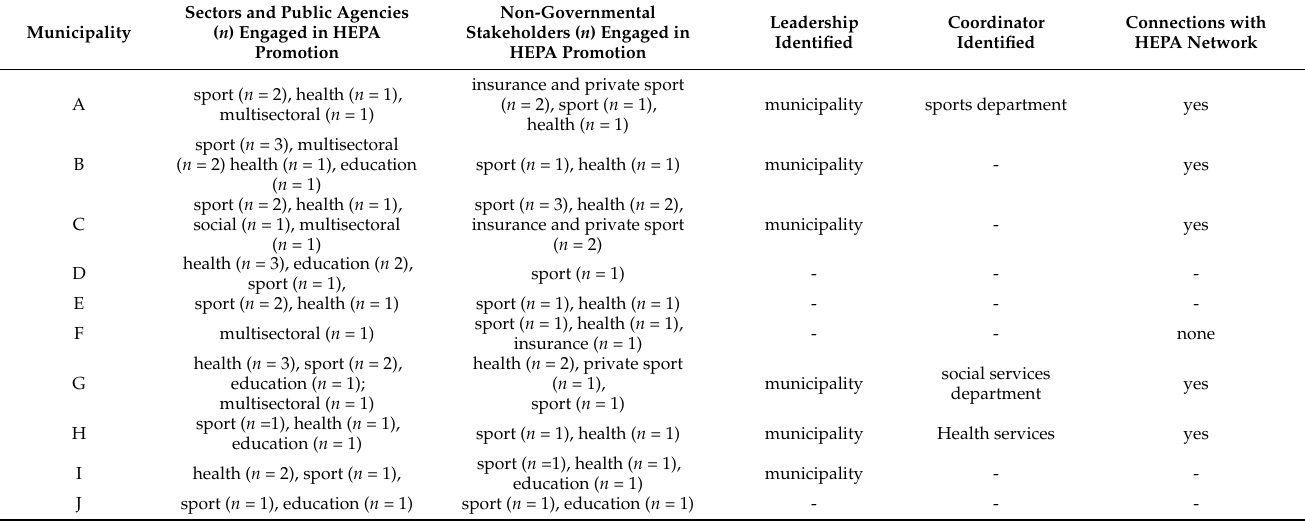
Table 2. Overview of HEPA stakeholders in the local government